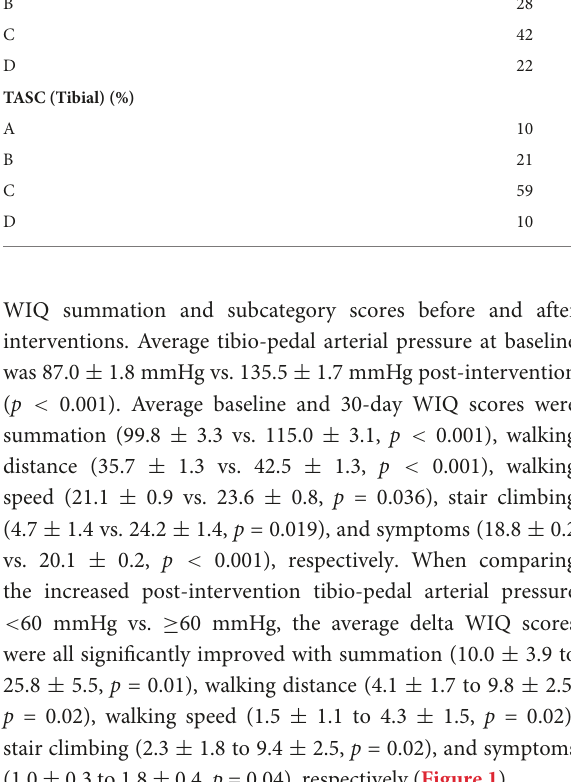
TABLE 1 Baseline patient characteristics.